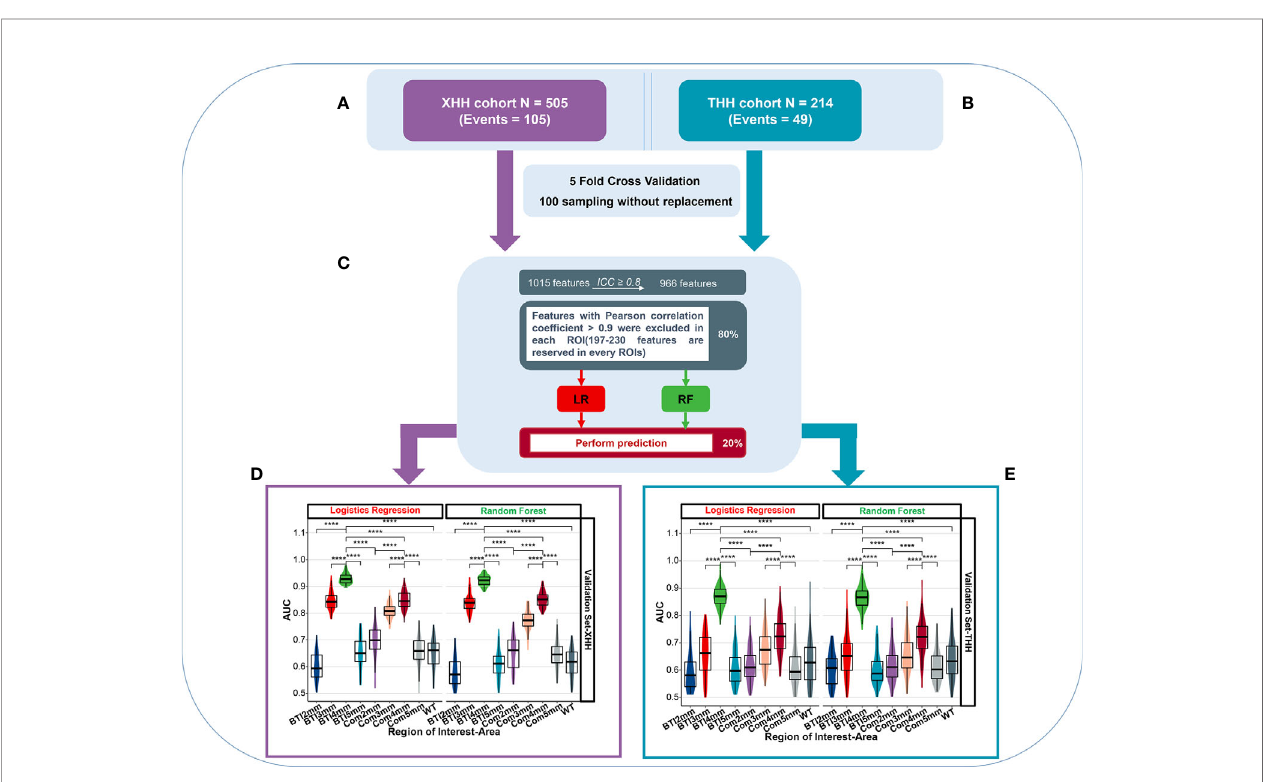
FIGURE 3 | The overall predictive performance of invasive meningioma in different ROI areas between two independent cohort. (A) Patients were split into the XHH cohort ( n = 505) and the THH cohort ( n = 214). (B) During feature selection and classi fi er establishment, fi vefold cross-validations of 100 sampling without replacement were used. (C) Schematic representation of feature selection and classi fi er building. (D, E) Violin plot of the AUC value distribution of different ROI areas in the XHH cohort (left side) and the THH cohort (right side). ****p <